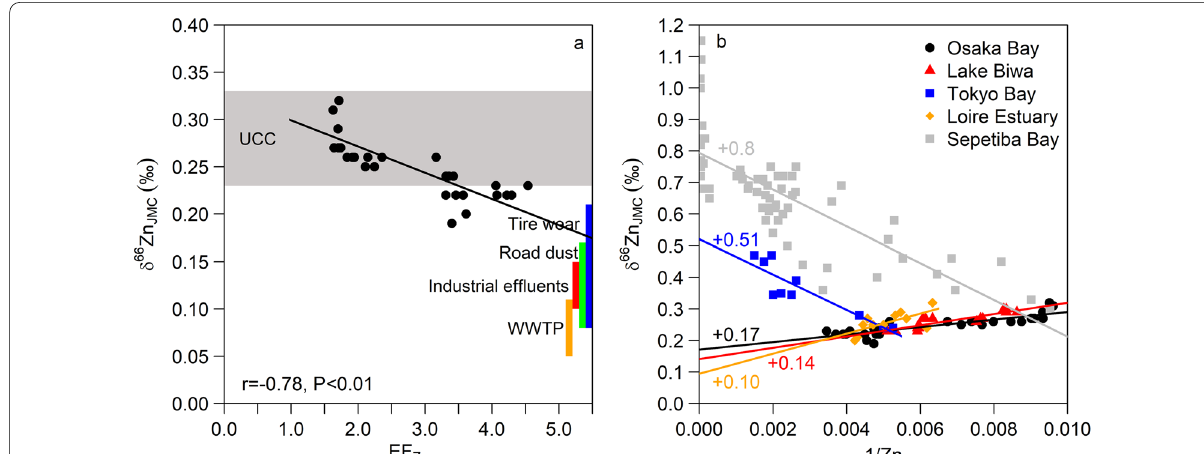
Fig. 10 a Scatter plot of δ 66 Zn against the Zn enrichment factor (EF Zn ), and b against 1/Zn in the piston core from Osaka Bay, in a core from Lake Biwa (Nitzsche et al. 2021), in a core from Tokyo Bay (Sakata et al. 2019), in a core from the Loire Estuary, France (Araújo et al. 2019b), in the cores from Sepetiba Bay, Brazil (Araújo et al. 2017; Tonhá et al. 2020). The black lines represent regression lines through all points. The δ 66 Zn values of the anthropogenic endmembers in b were estimated from the intercepts of the regression lines. Extending the regression line in a to 0.17 ‰ yields + an average EF Zn of the anthropogenic endmember of ~ 5.5. The δ 66 Zn value of the upper continental crust (UCC) was obtained from Chen et al. (2013). The range in δ 66 Zn values of urban and industrial sources includes industrial effluents ( 0.10 ‰ to 0.15 ‰) (Desaulty and Petelet-Giraud + + 2020), road dust ( 0.08 ‰ to 0.17 ‰), tire wear ( 0.08 ‰ to 0.21 ‰) (Dong et al. 2017; Souto-Oliveira et al. 2018; Thapalia et al. 2010), and + + + + wastewater treatment plants (WWTP; 0.06 ‰ to 0.08 ‰) (Chen et al. 2008; Desaulty and Petelet-Giraud 2020) + +